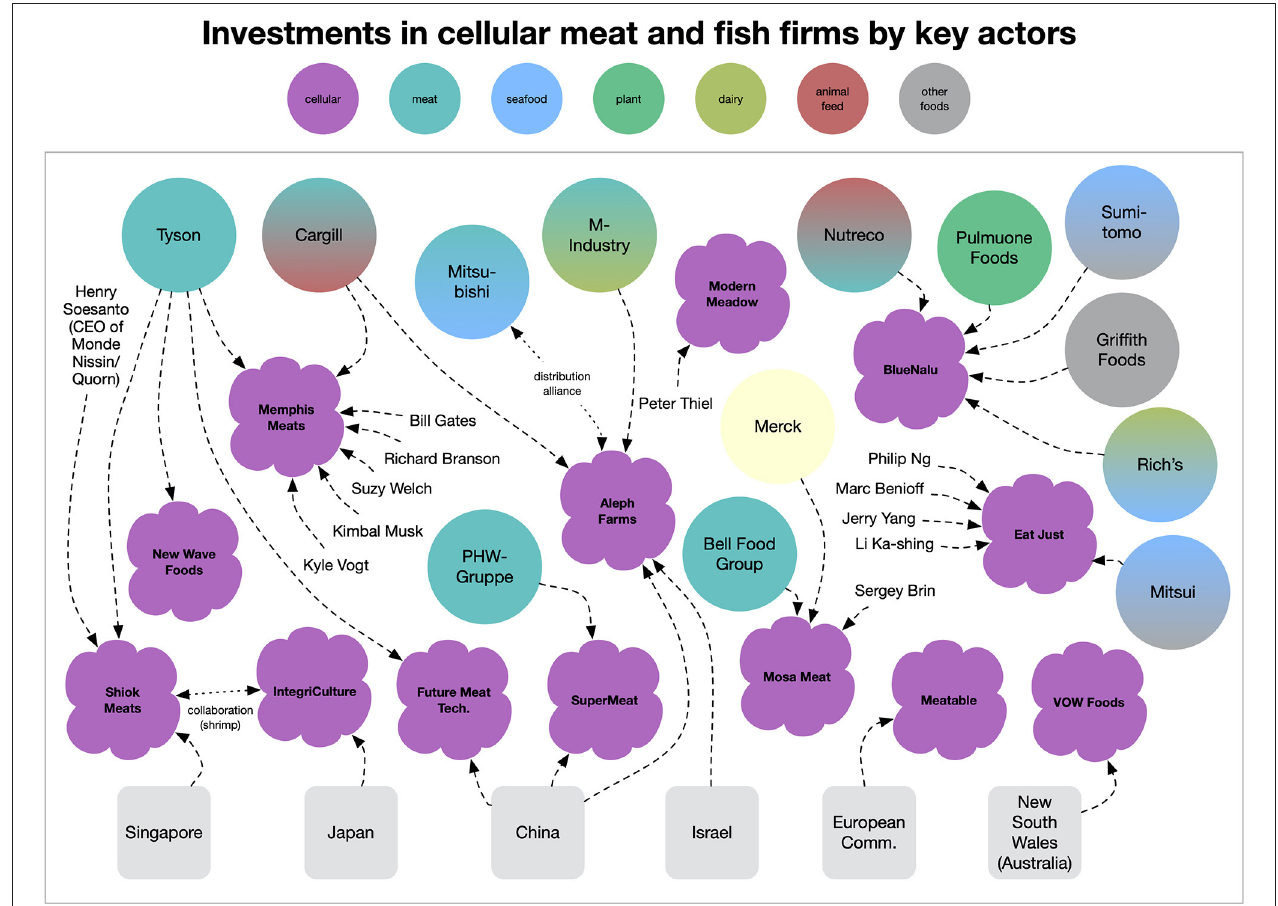
FIGURE 5 | Diagram of investments in cellular meat and fish firms by key